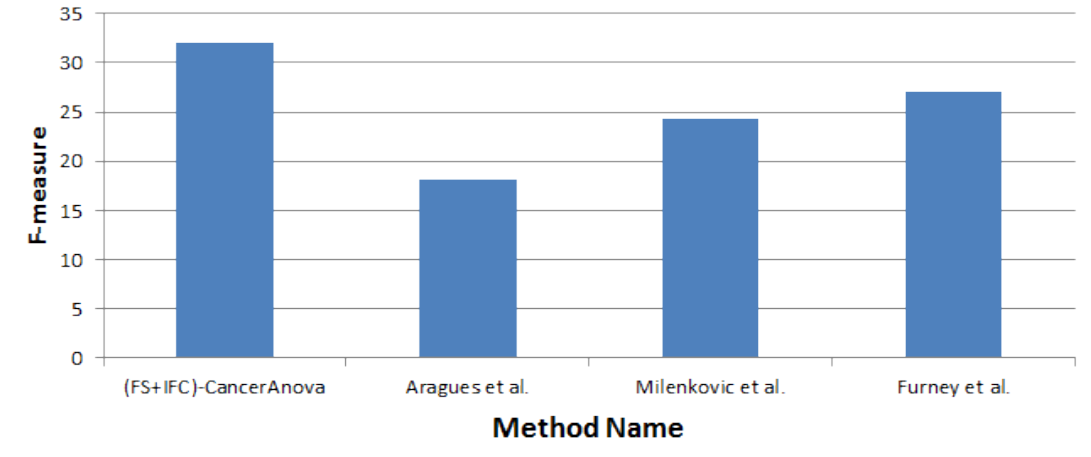
Figure 6: Comparing with previous methods. The method (FS+IFC)-DisToCancerAnova which considers network contextual information outperforms the previous methods (Furney et al. [25], Aragues et al. [22] and Milenkovic et al. [24]), by 5%, 13% and 8%, respectively, with respect to